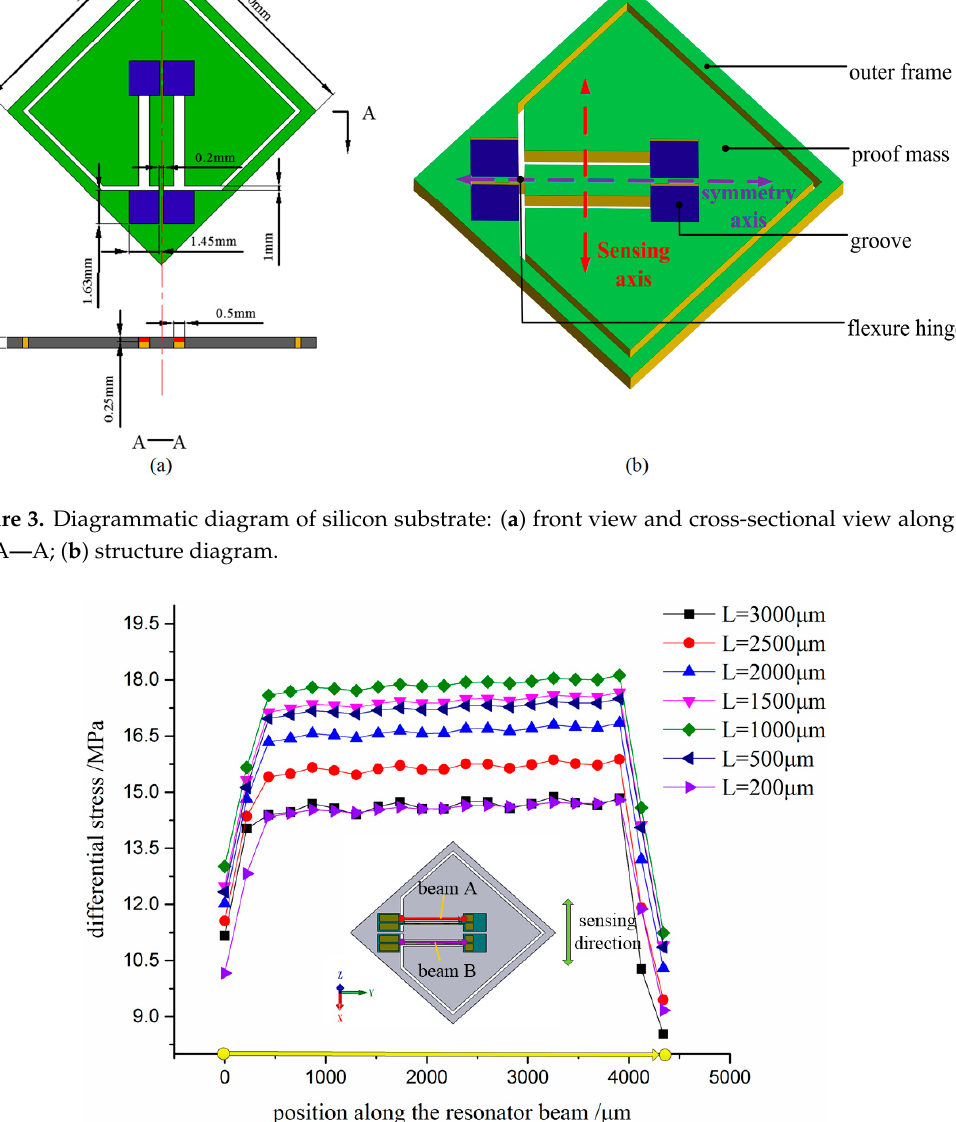
Figure 4. Differential stress distribution along the selected resonator beam versus length of flexure hinge (width is 200 μ m; thickness is 500 μ m).